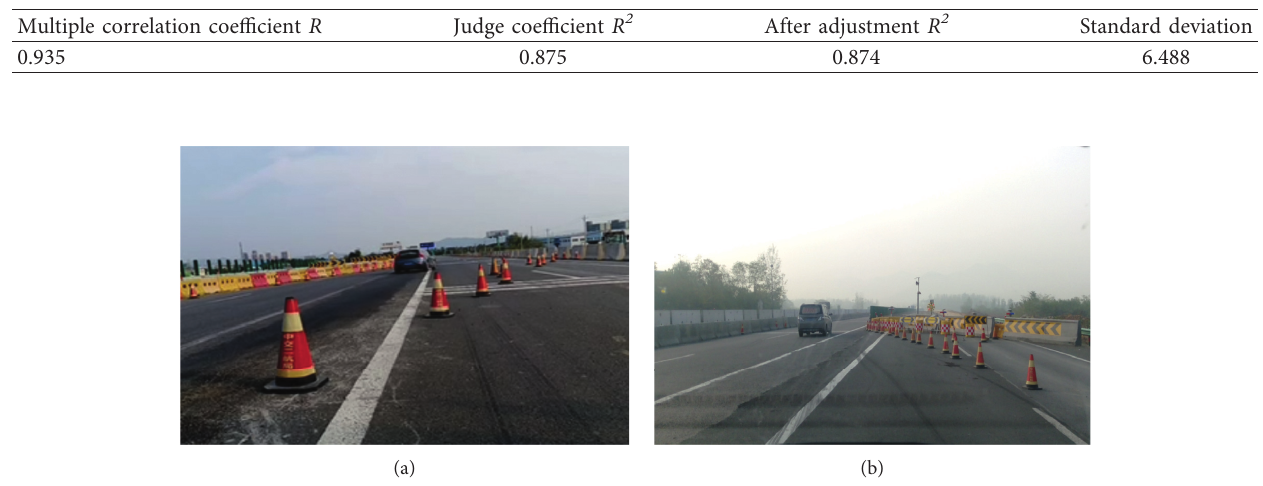
Table 5: The goodness of fit test of the driving risk model.